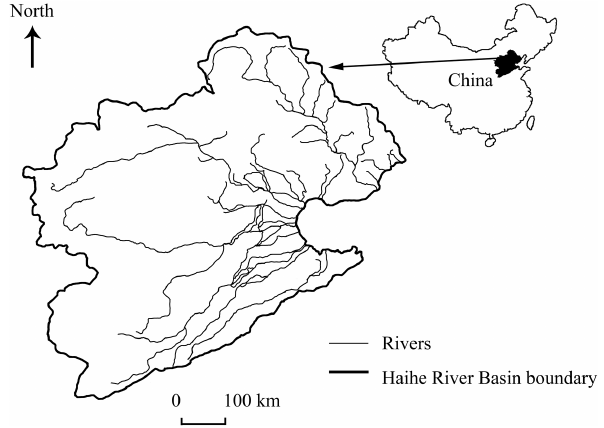
Fig. 1. Location of study area (adapted from website of Haihe River Water Conservancy Commission http://www.hwcc.gov.cn/